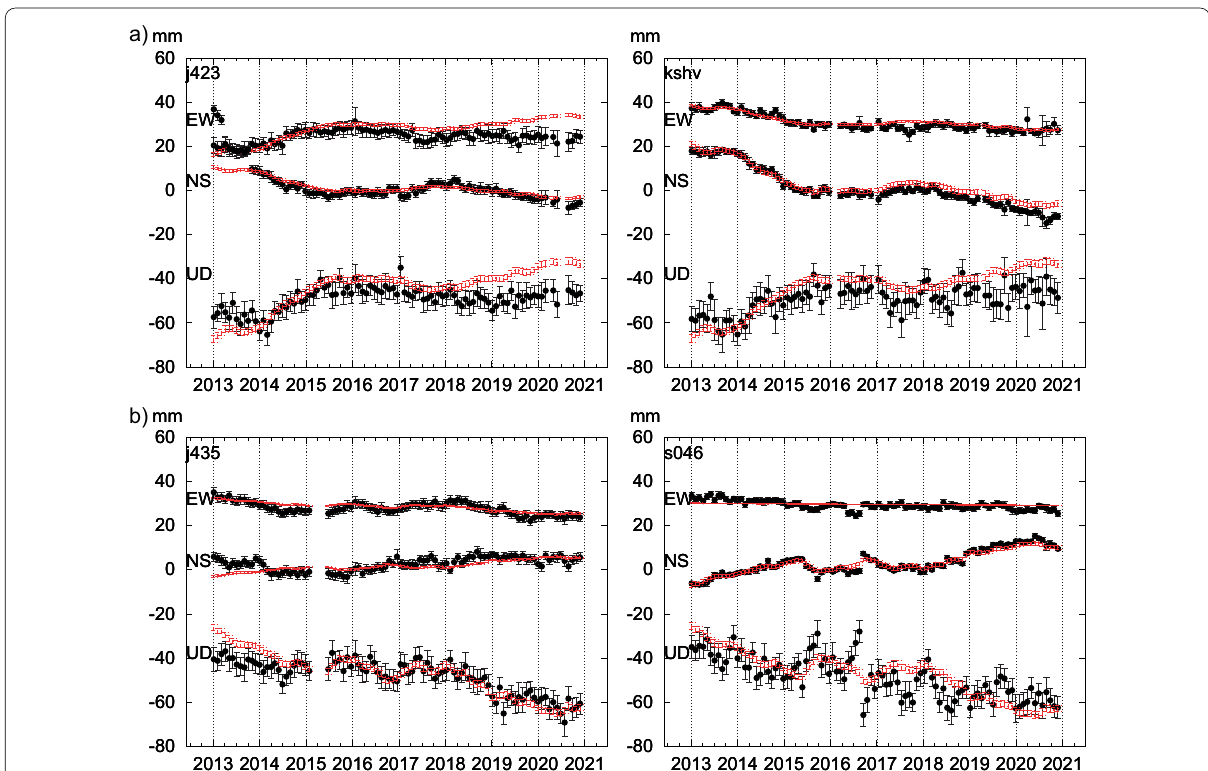
Fig. 7 Observed and calculated GNSS coordinate time series after linear inversion at selected sites. a Selected GNSS coordinate time series for sites around Kusatsu-Shirane volcano. Black and red points represent the observed and calculated GNSS coordinate time series, respectively. Error bars on black points represent one sigma observation error. Those on red points represent predicted errors from errors on the estimated strengths (one sigma). b Selected GNSS coordinate time series for sites around Asama volcano. Legends are the same as a . Complete GNSS coordinate time series are given in Additional file 3: Figure S3a,